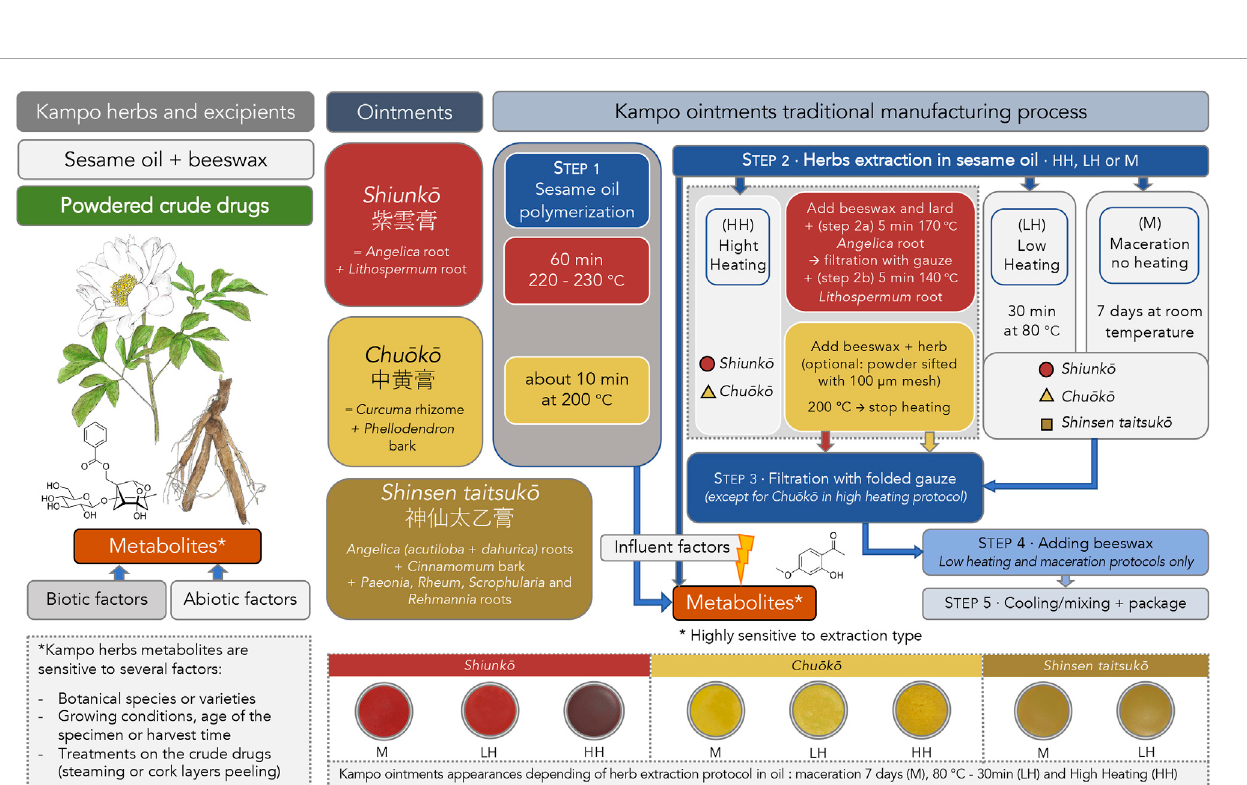
FIGURE 1 Descriptivediagram presentingthetraditionalmanufacturingprocessforKampo ointments ( Shiunk ō ,Chu ō k ō , and Shinsen taitsuk ō )anditsimplications on herb metabolites and ointments appearances.